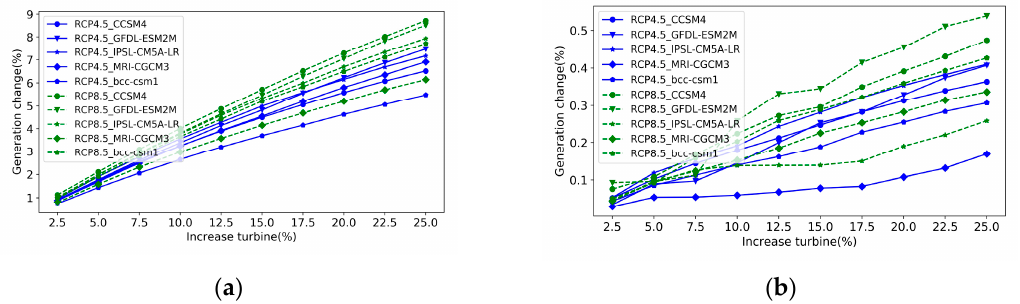
Figure 12. The generation change with the addition of turbine capacity of Gongguoqiao. ( a ) Increased power generation of Gongguoqiao, and ( b ) increased power generation of LCCHS.